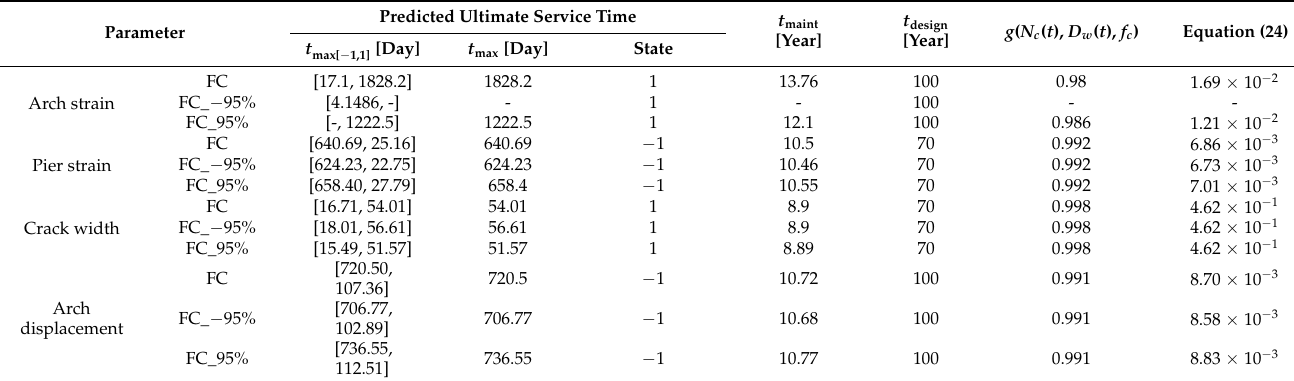
Table 12. Results of system maintenance decision